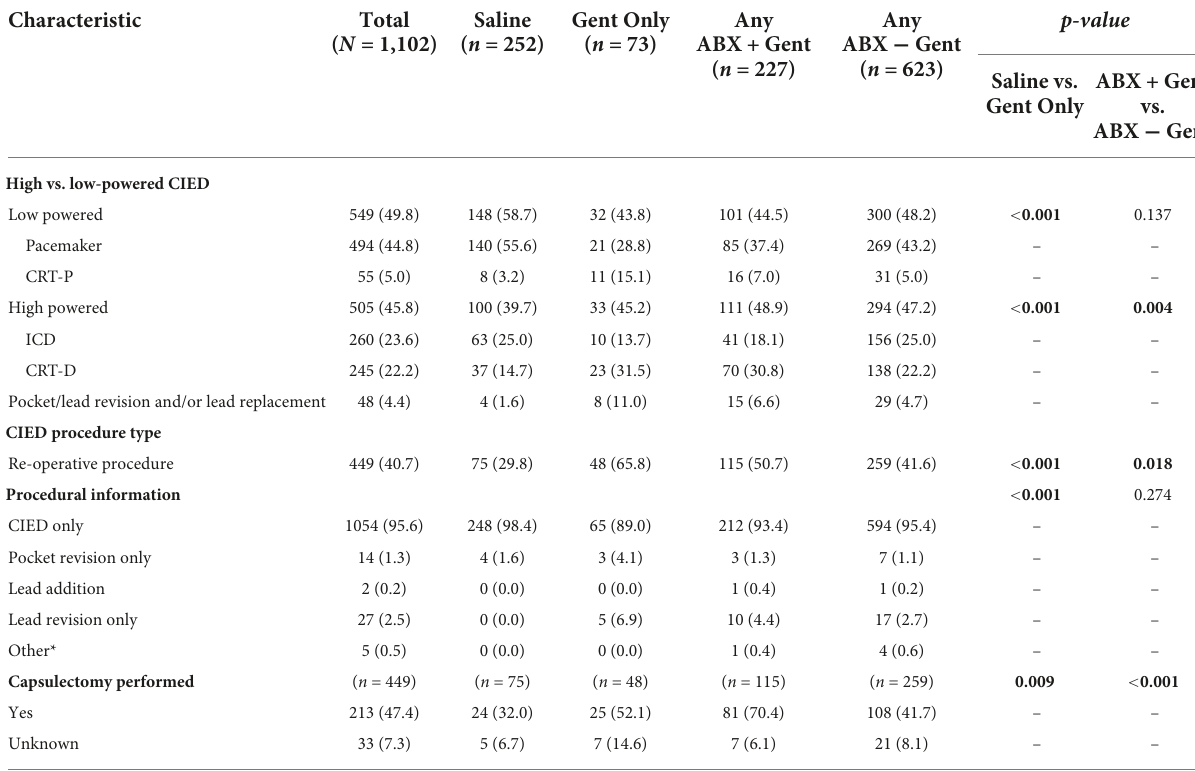
TABLE 3 Device and procedural